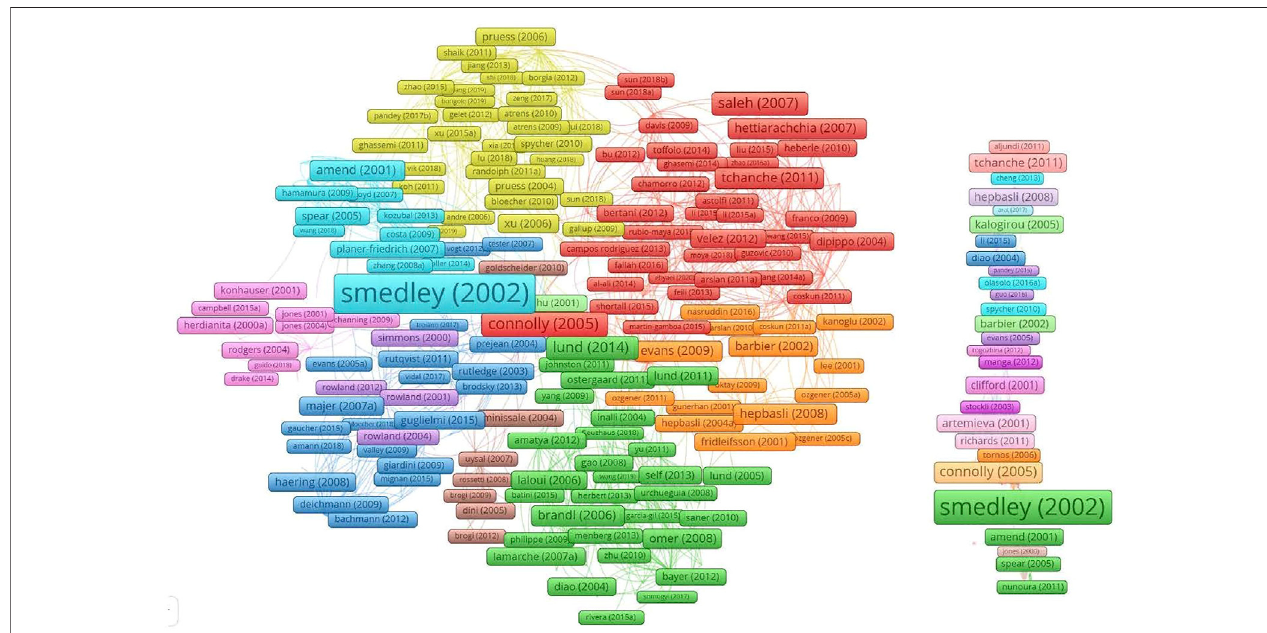
FIGURE 7 | Citation of references and bibliographic coupling of documents.